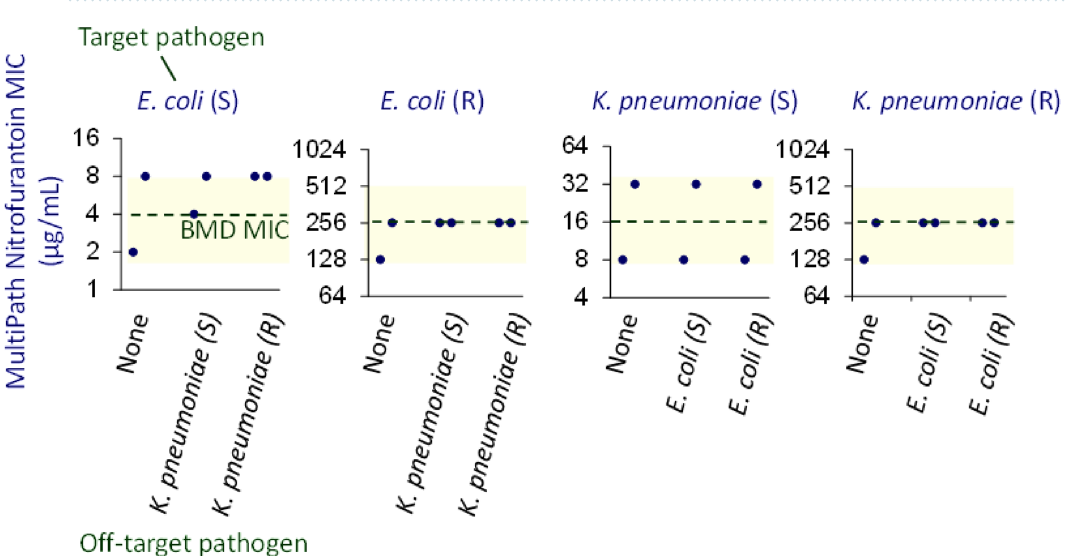
Figure 8. MultiPath AST accuracy for multiple pathogens in a sample. MultiPath nitrofurantoin susceptibility results (MIC) are shown for each pathogen in a sample containing two pathogen species compared to the result for that pathogen alone (n = 2). The strains were E. coli ARLG 1021 (S), E. coli BI 703 (R), K. pneumoniae CDC 142 (S), and K. pneumoniae CDC 555 (R). The dashed line denotes the MIC result for the target pathogen found using the BMD reference method. The yellow shaded area shows the limits of essential agreement with the BMD method. CLSI breakpoints for these pathogens with nitrofurantoin are S ≤ 32, I = 64, R ≥ 128